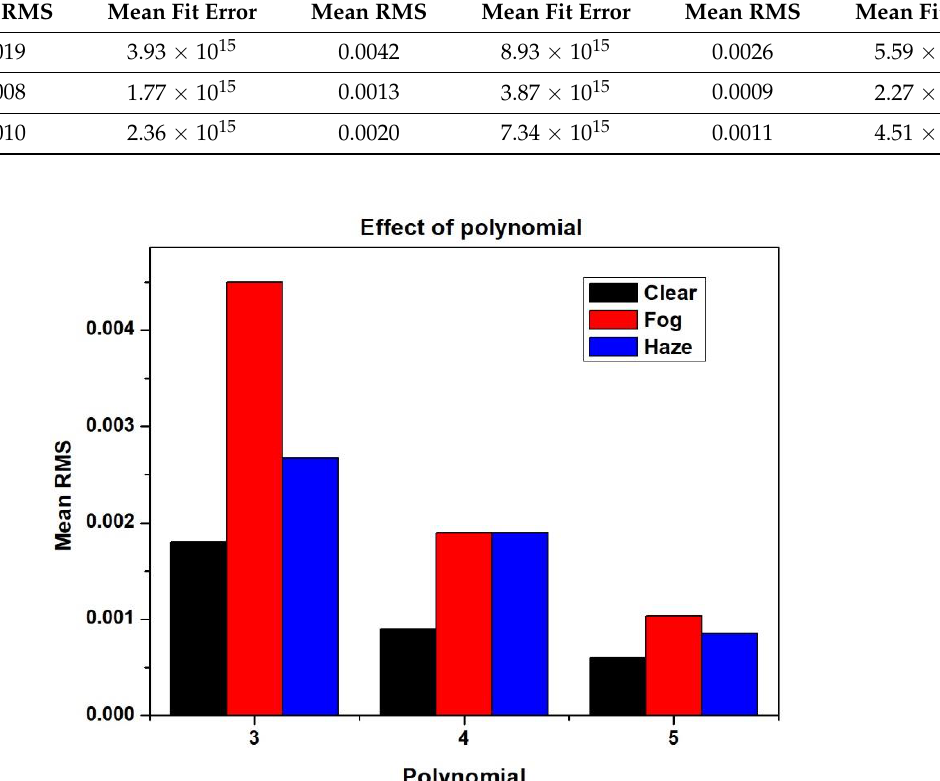
Table 4. Mean RMS and mean fit error at different fitting windows during different meteorological conditions. Fitting